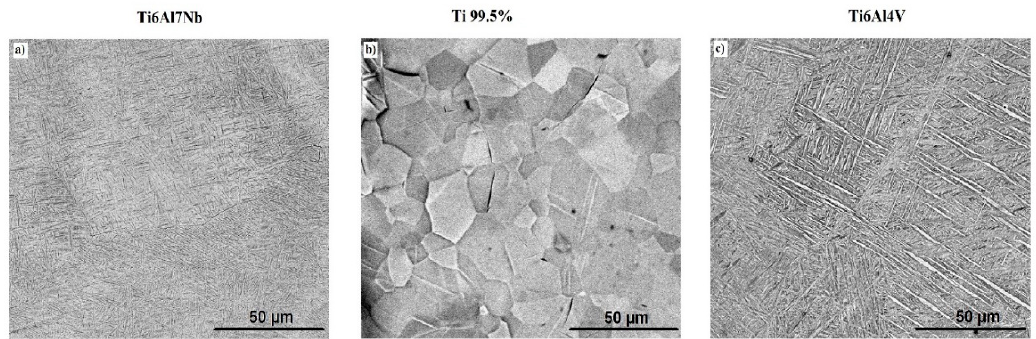
Figure 1. The structure of the base (Ti6Al7Nb ( a ) and Ti6Al4V ( c )) and the referential Ti (Ti 99.5% ( b )) alloys substrate.